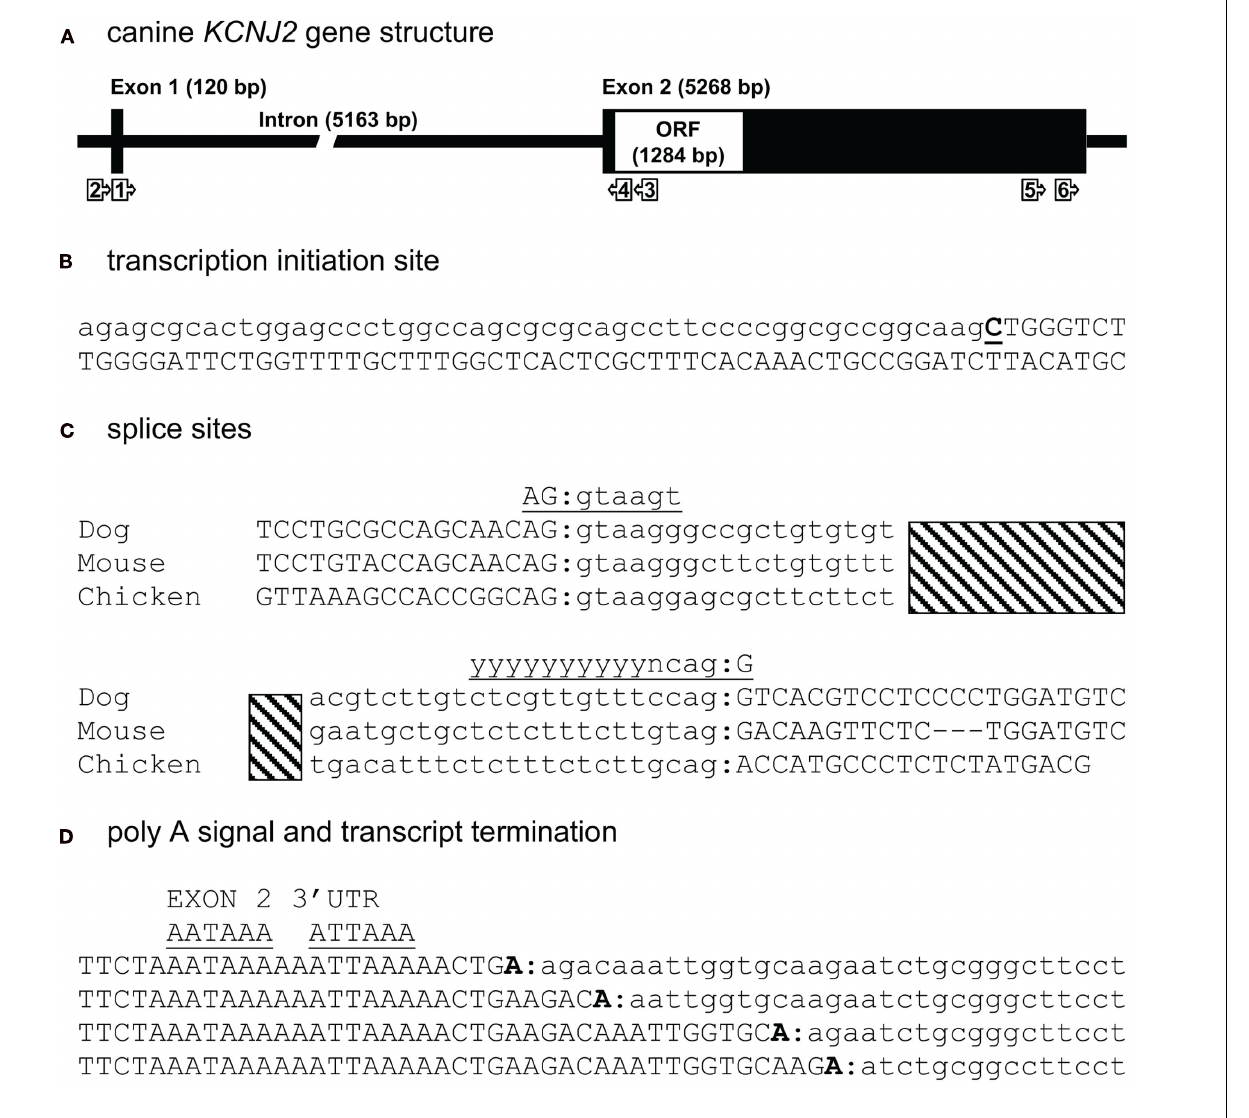
chicken KCNJ2 genes. Hatched bar indicates intron region. Exon 1 and exon 2 sequences are indicated in upper case lettering, intron sequence in lower case. Consensus splicing sequences are indicated above the sites (underlined). (D) Four alternative 3 (cid:2) transcript termini (bold). Exon 2 sequences are indicated in upper case, downstream genomic sequences in lower case. Consensus termination signals are indicated above the sequences